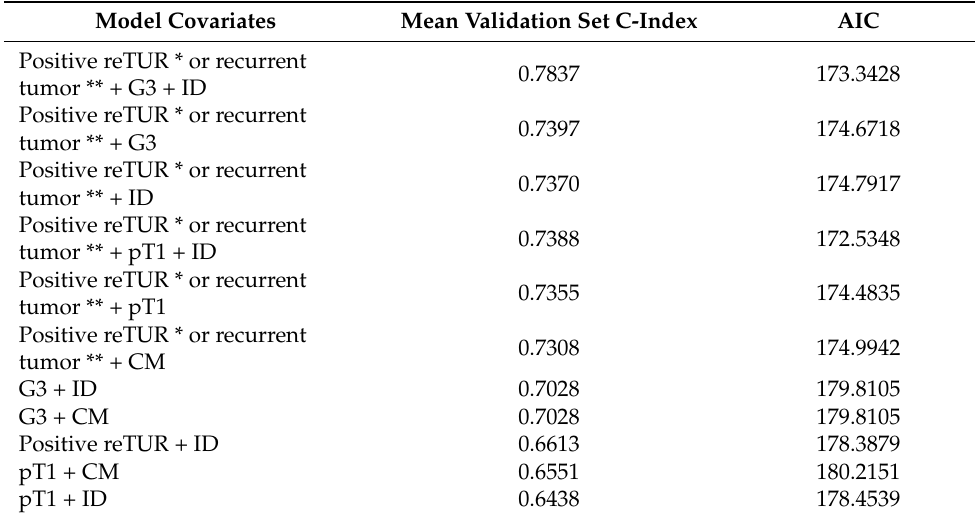
Table 3. Performance of multivariable Cox regression models (CM—center of mass, ID—immunodrop). Model Covariates